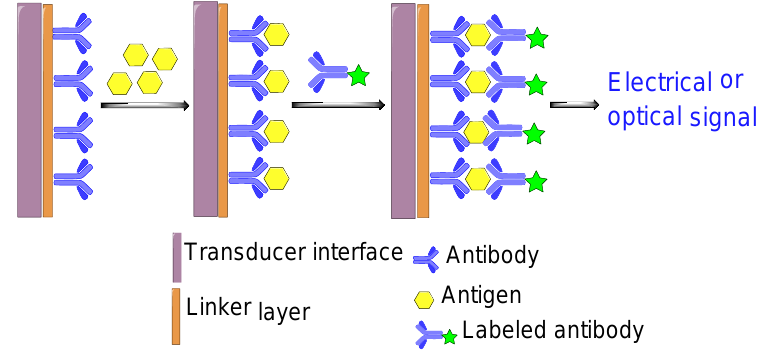
Figure 5. Schematic diagram of labeled antibody-based immunosensor.